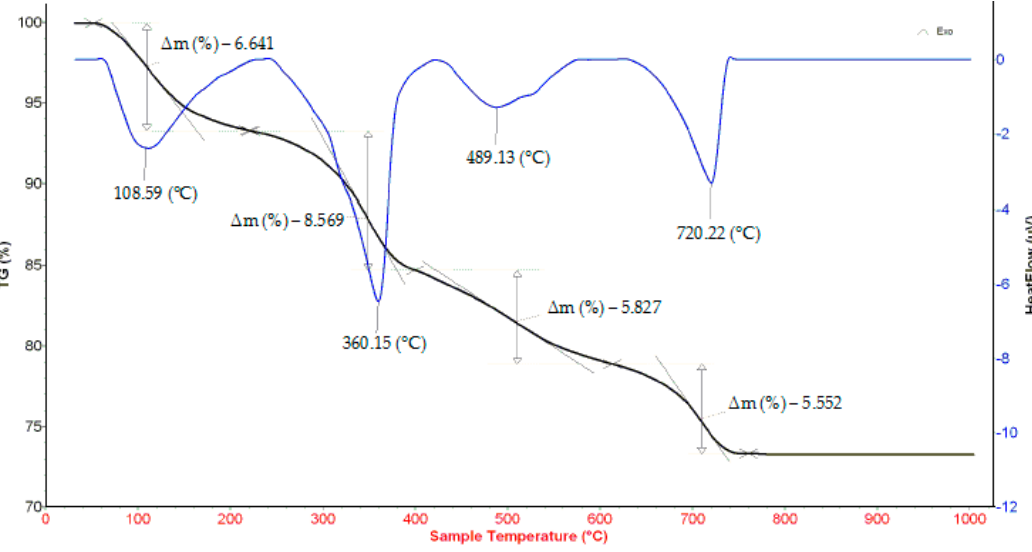
Figure 2. TGA / DSC results of the precipitate containing Nd Figure 2. TGA/DSC results of the precipitate containing Nd (III).